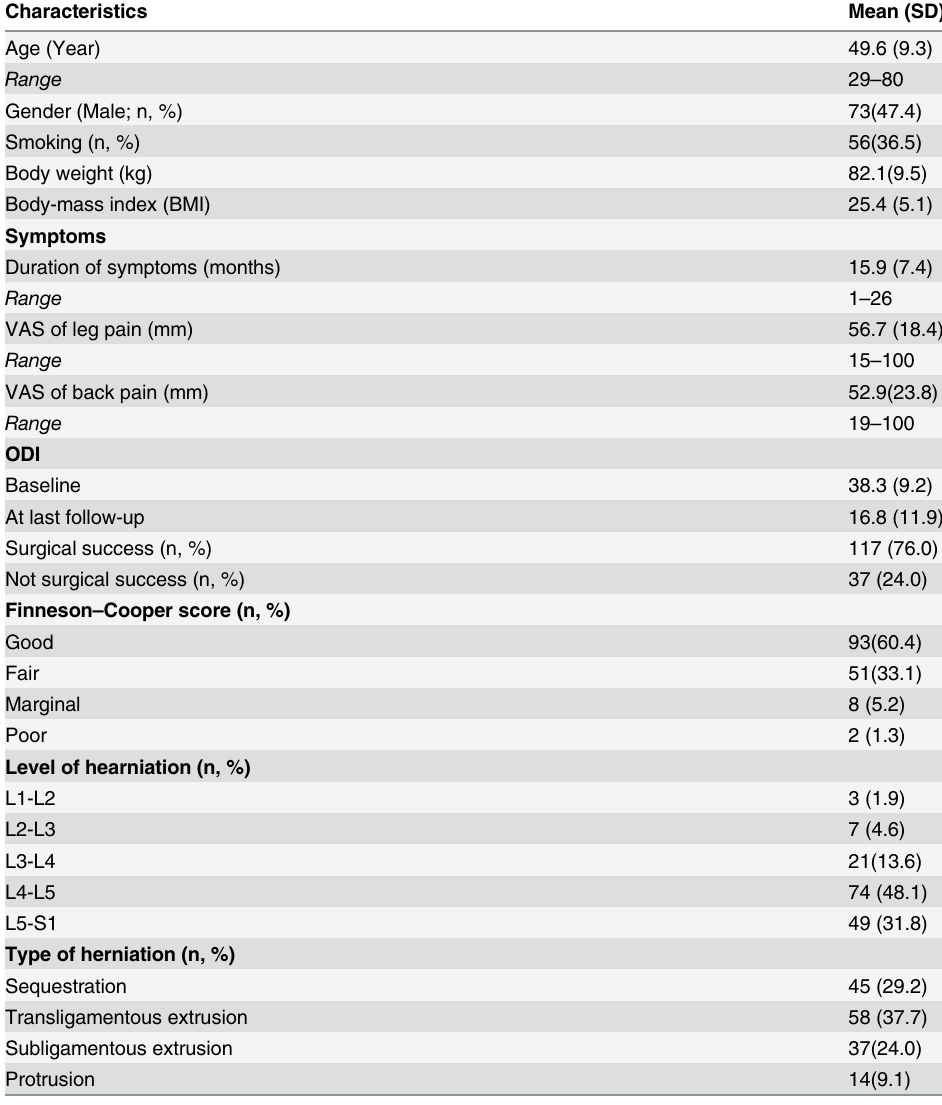
Table 1. Demographic data and preoperative status of patients with lumbar disc herniation (n = 154).